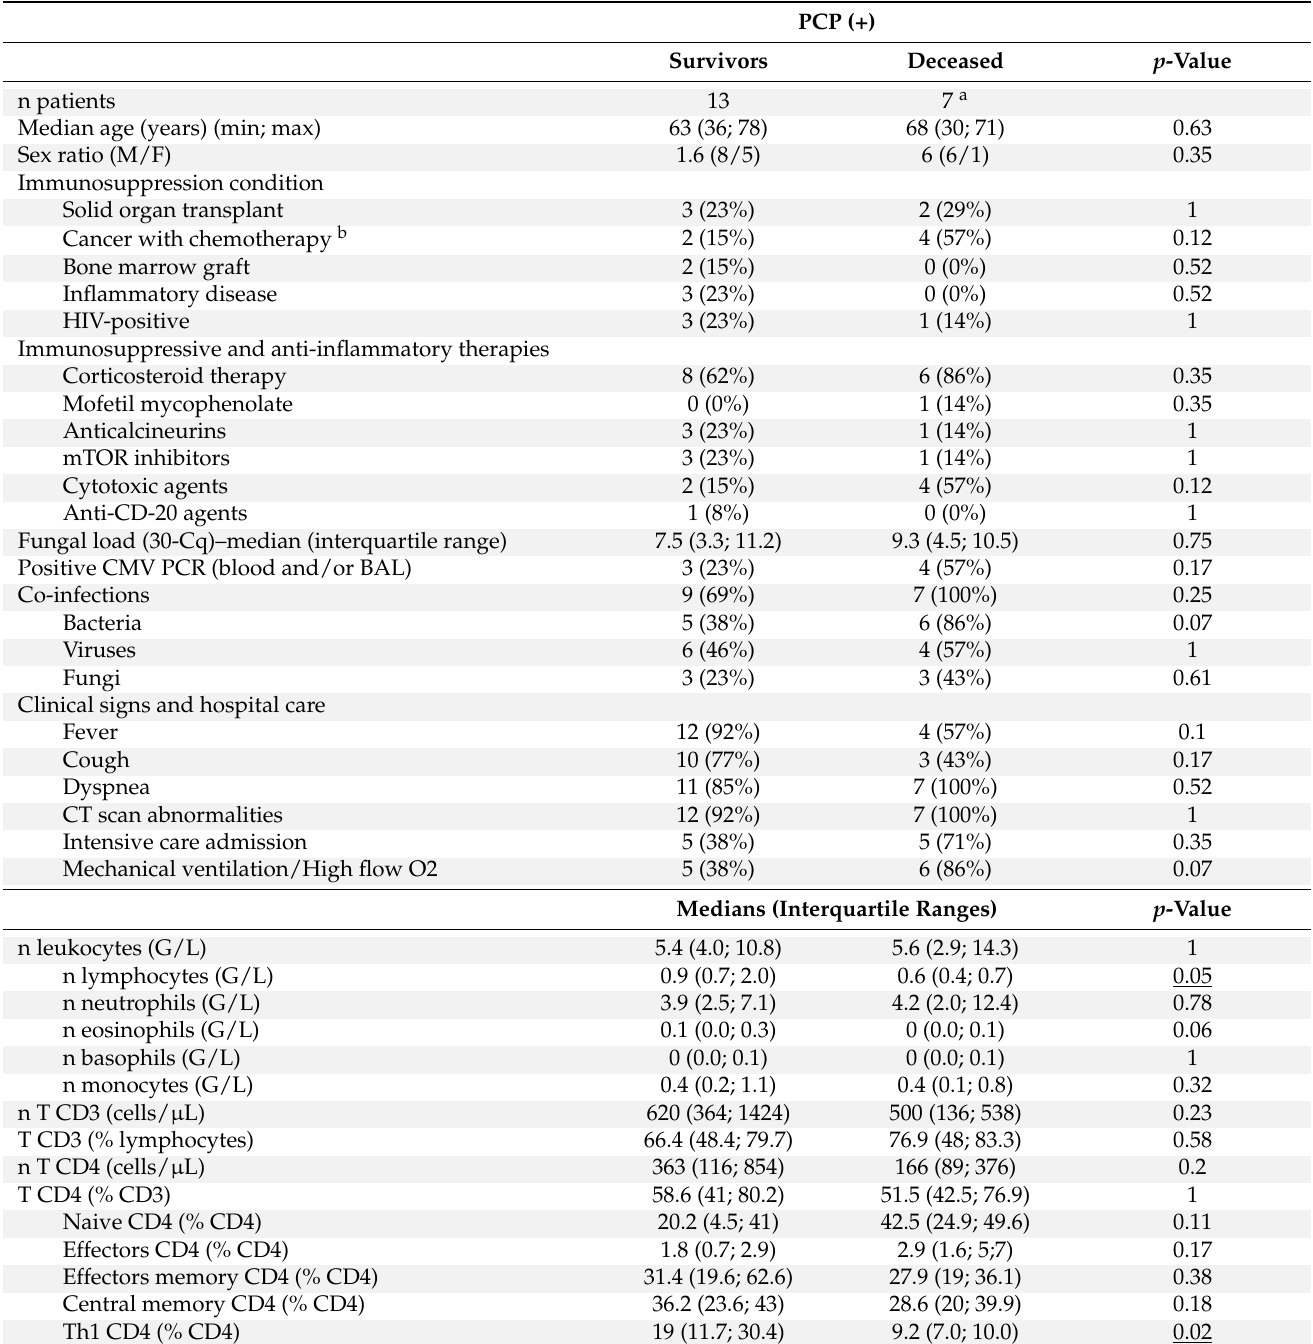
Table 3. Comparison of clinical characteristics and lymphocyte populations in survivors and non-survivors of the PCP(+) group.